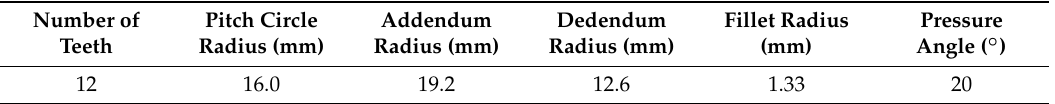
Table 3. Main parameters of the identified spur